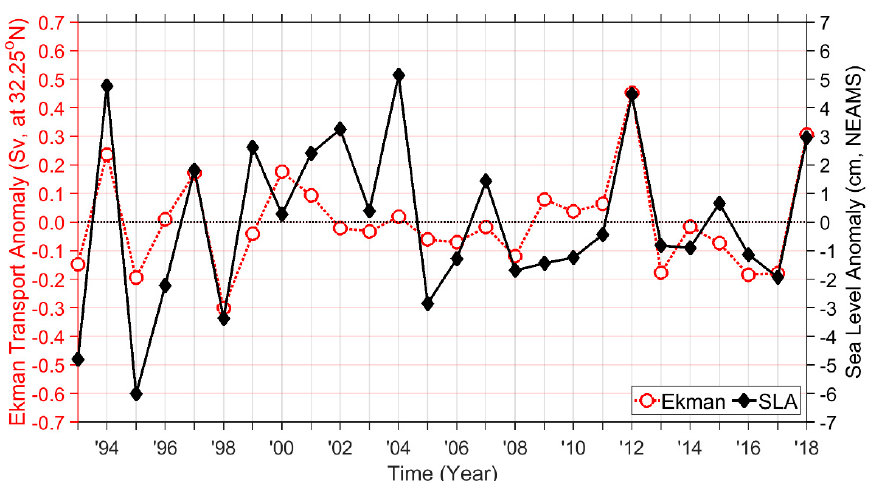
Figure 4. Time-series of the meridional Ekman transport anomaly, along the 32.25°N (blue dotted line in Figure 1) from the east coast of China to the west coast of Japan (dotted red), and the de-trended mean sea-level anomalies averaged over the NEAMS (solid black) from satellite altimetry data in August from 1993 to 2018. The correlation coefficient between the sea-level anomaly and the meridional Ekman transport anomaly is 0.69 (p-value < 0.01).